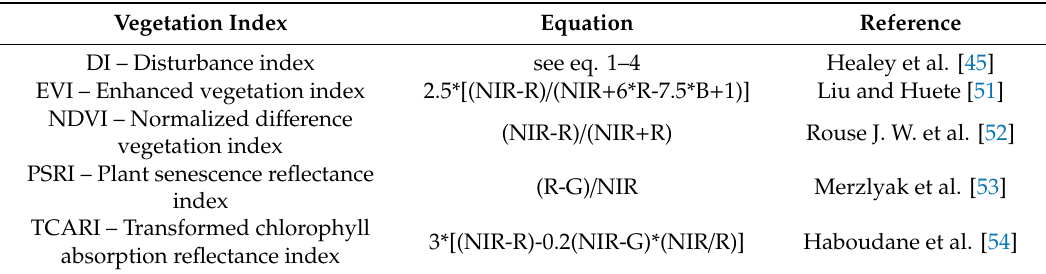
Table 2. Summary of vegetation indices computed from Landsat image data in this study (B – blue, G – green, R – red, and NIR – near-infrared